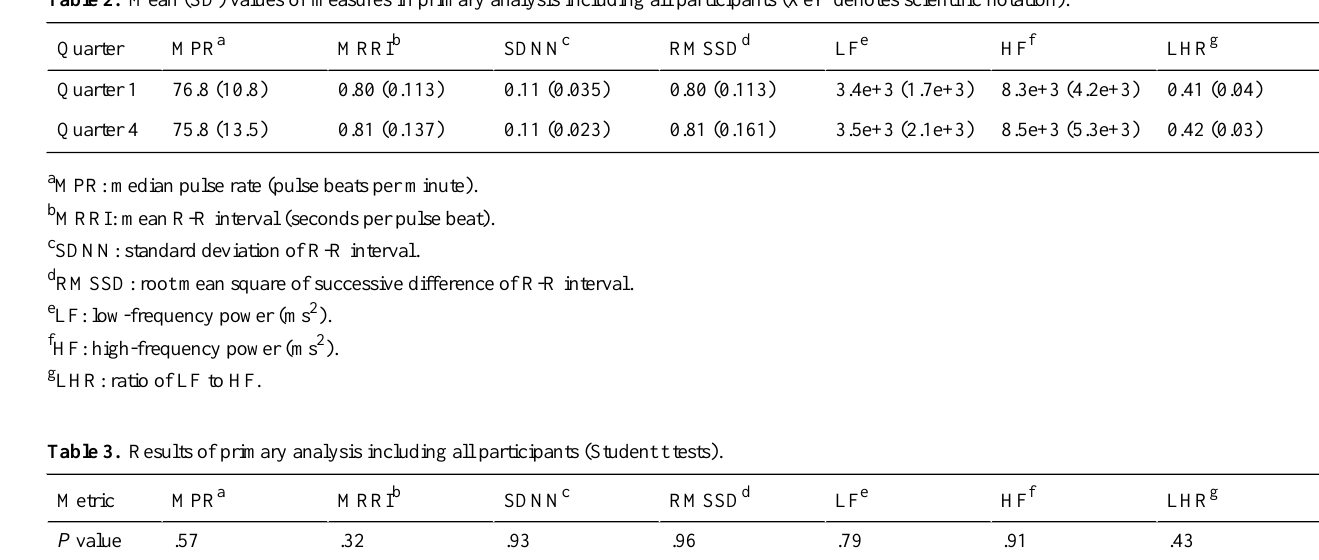
Table 2. Mean (SD) values of measures in primary analysis including all participants (XeY denotes scientific notation).